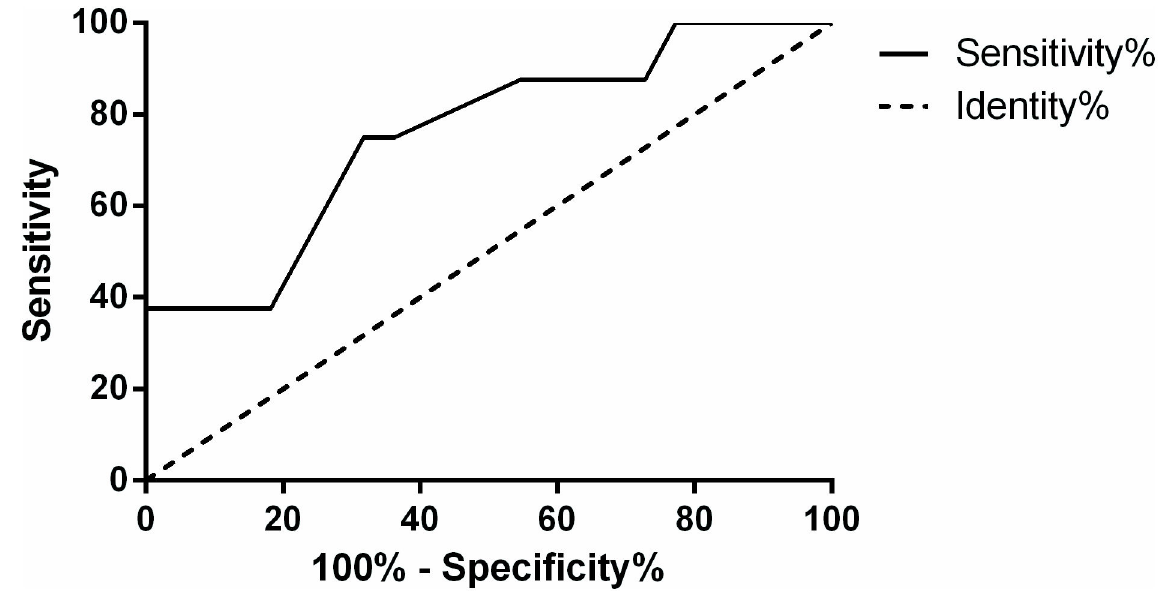
Figure 5. ROC curve with AUC for urine IgG to albumin ratio at the time of diagnosis.